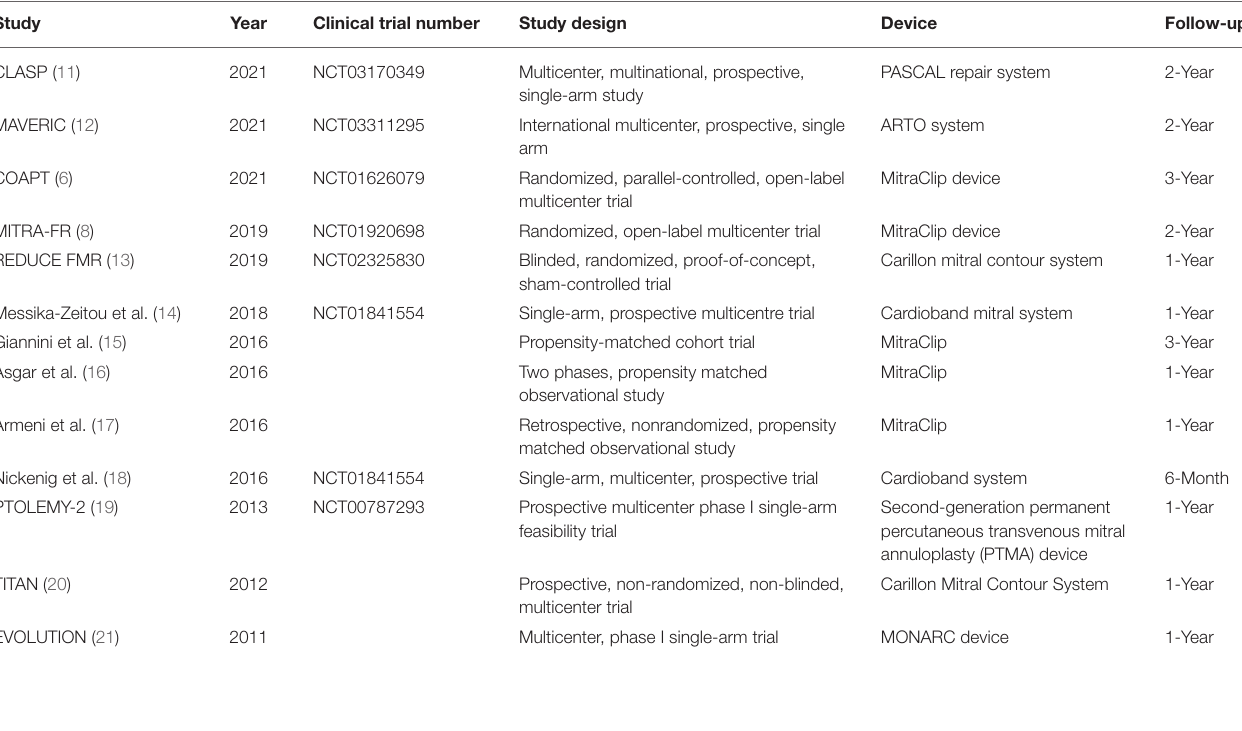
TABLE 1 | Information of included studies.